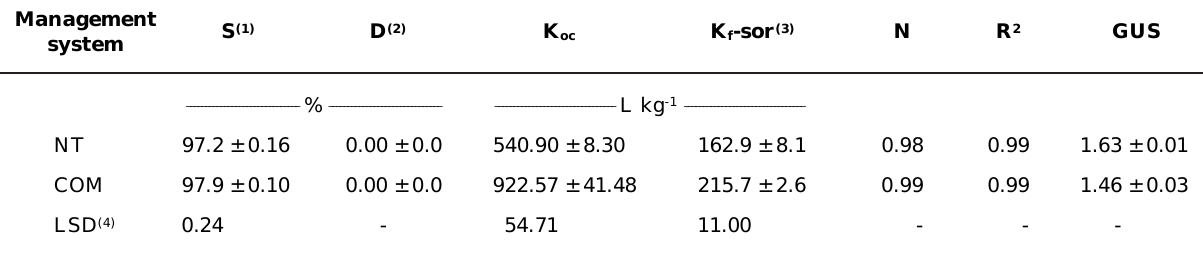
(1) Glyphosate sorbed. (2) Glyphosate desorbed. (3) Freundlich sorption constant. (#) Freundlich desorption constant. (4) Calculated by Tukey’s test (p <